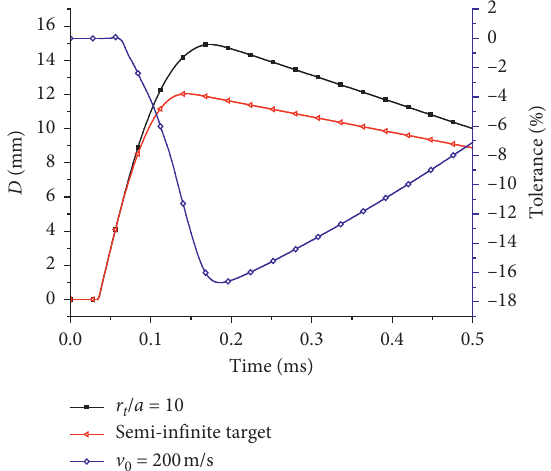
Figure 15: Deviation comparison of the penetration depth for the free boundary ( r t / a � 10) and the nonreflecting boundary ( v � 200m/s).